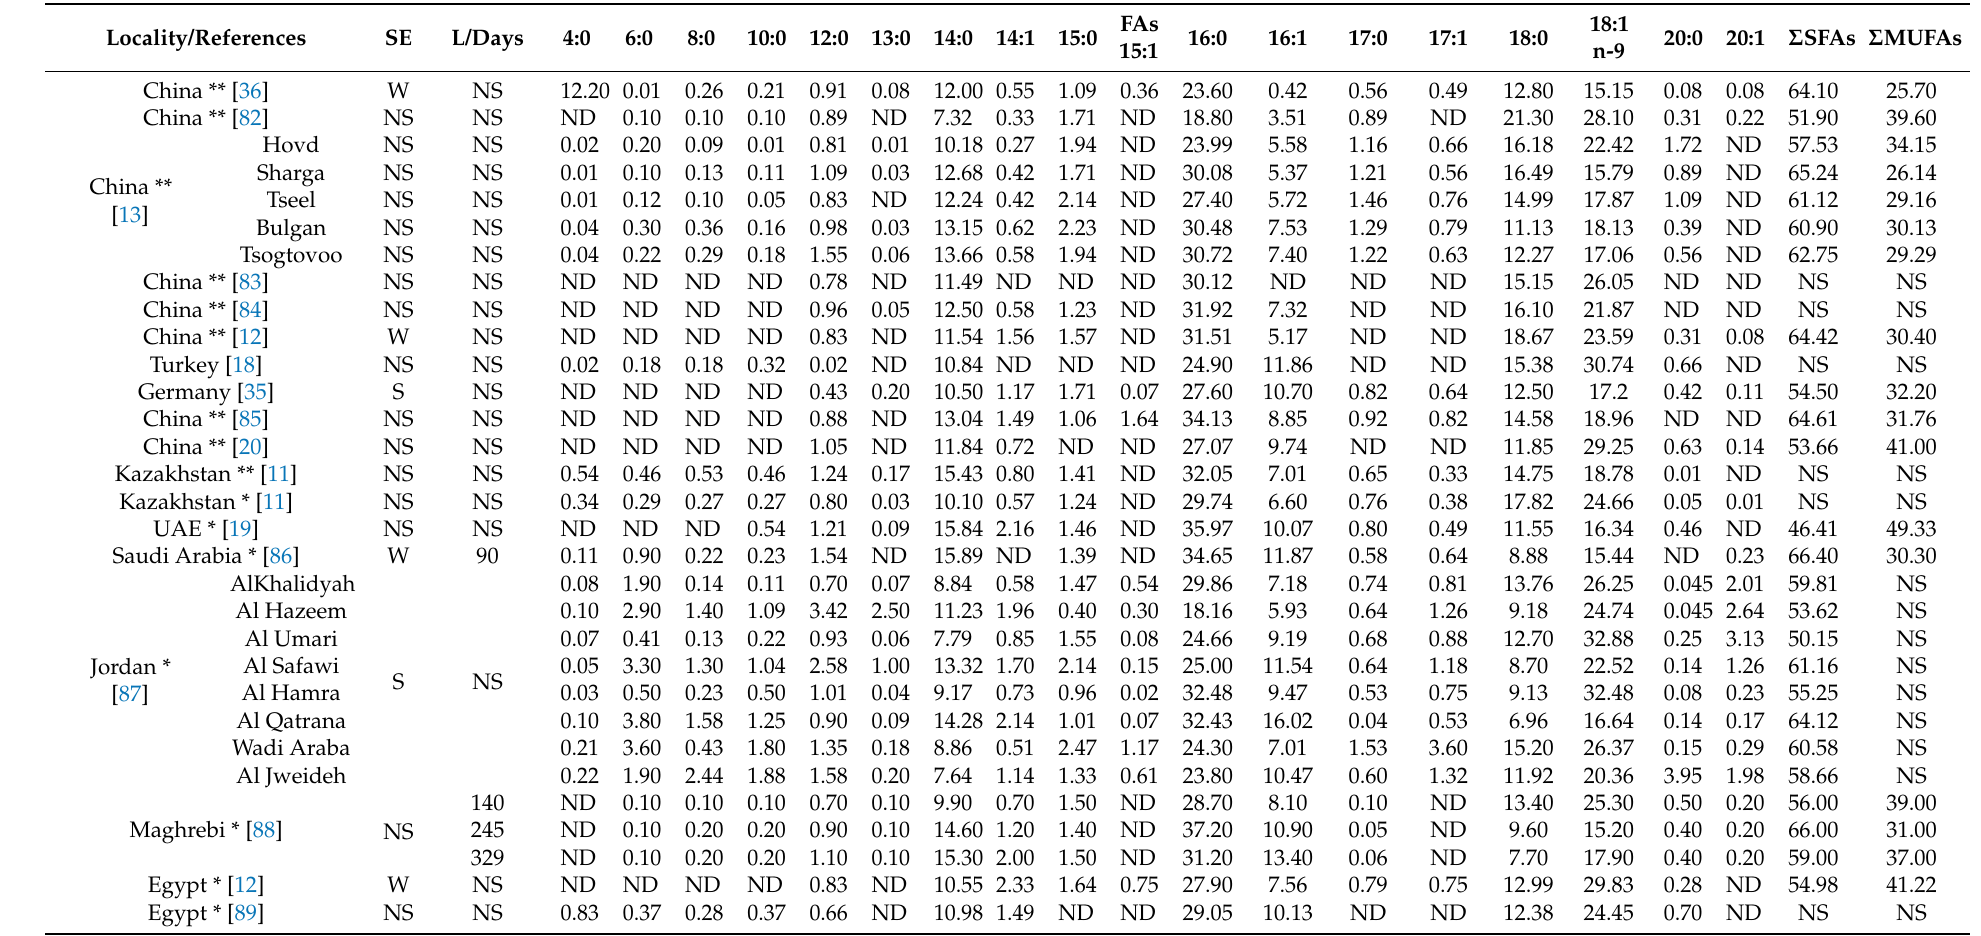
Table 1. Composition of saturated and monounsaturated FAs in camel milk from four different